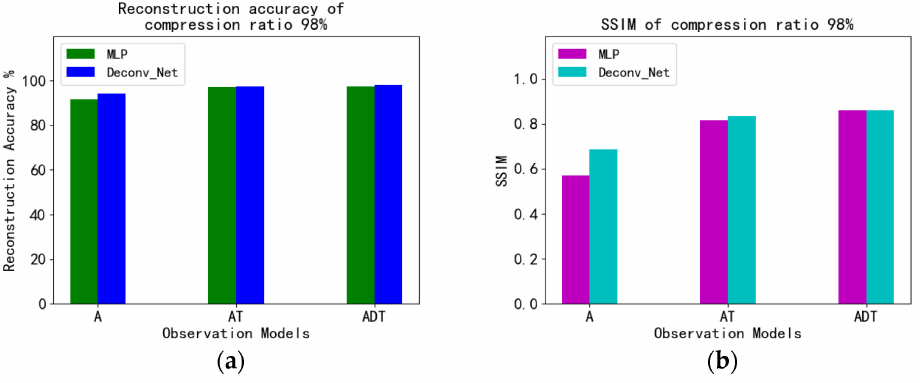
Figure 15. Comparison of reconstruction accuracy ( a ) and SSIM ( b ) between MLP and Deconv at a compression ratio of 98%.